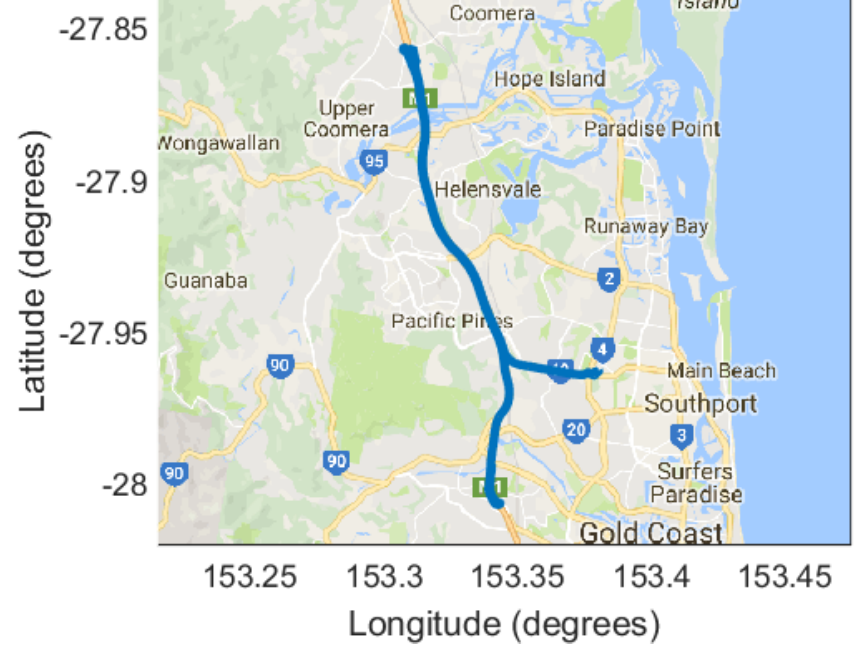
Figure 5. Motorway section of the driving